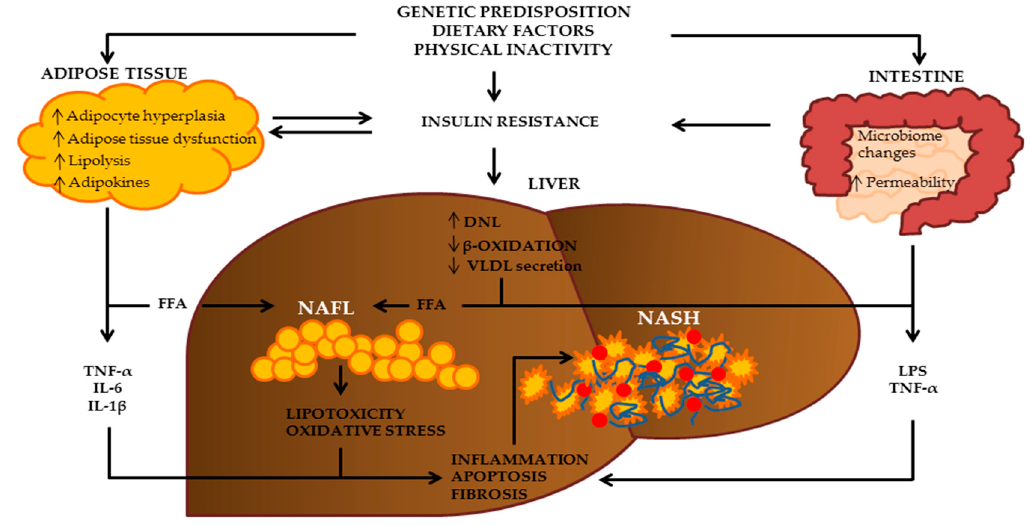
Figure 1. Pathogenesis of NAFLD. Based on the “multiple hit” model, dietary habits, insulin resistance, visceral adiposity, inflammatory state, oxidative stress, alteration in microbiome, and genetic predisposition, are all recognized risk factors for NAFLD. DNL: de novo lipogenesis; FFA: free fatty acids; IL-6: interleukin-6; IL-1 β : interleukin-1 β ; LPS: lipopolysaccharide; NAFLD: non-alcoholic fatty liver disease; NASH: non-alcoholic steatohepatitis; TNF- α : tumor necrosis factor- α .